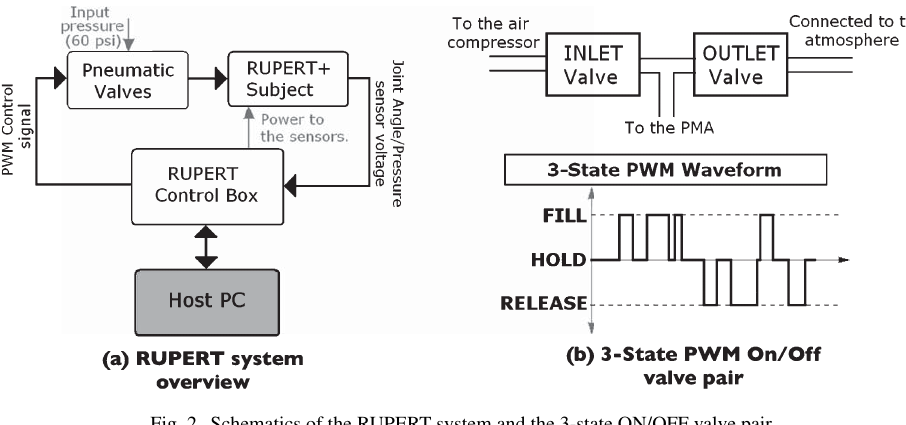
Fig. 2. Schematics of the RUPERT system and the 3-state ON/OFF valve